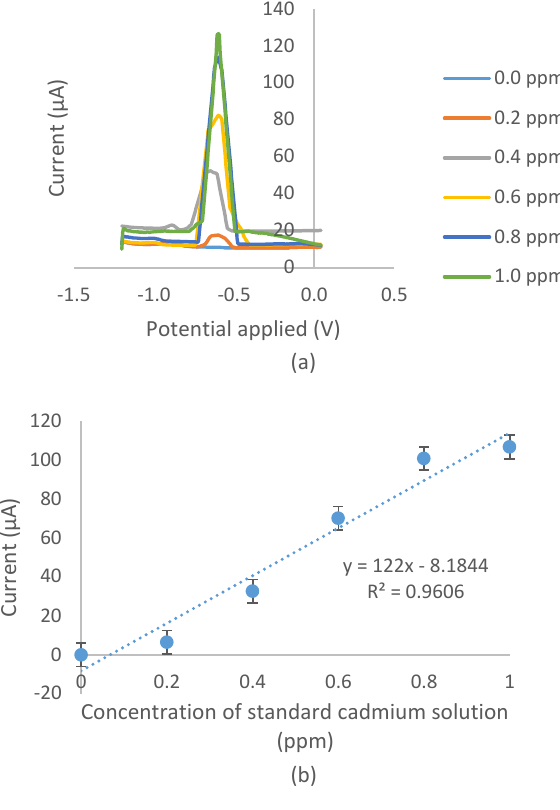
Figure 4. (a) Voltammogram for the series of standard cadmium so- lutions in an 0.01M acetate buffer with a pH of 4.5, a − 1 . 4V depo- sition potential and a 120s deposition time tested on bare the SPCE of the electrochemical sensor. (b) Standard calibration graph ob- tained from the series of standard cadmium solutions in the 0.01M acetate buffer with a pH of 4.5, a − 1 . 4V deposition potential and a 120s deposition time tested on the bare SPCE of the electrochemi- cal sensor.